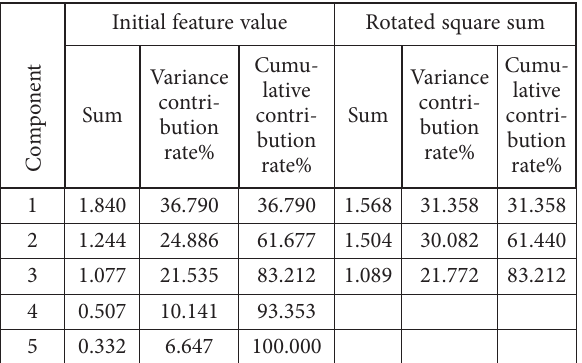
Table 1. Characteristic values and variance contribution rates